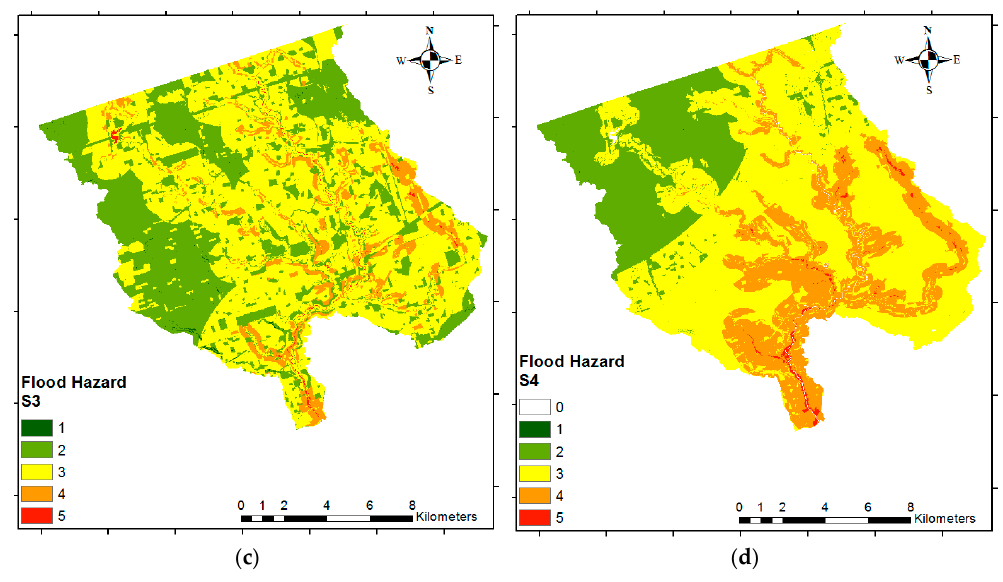
Figure 6. Flood hazard maps; ( a ) S1; ( b ) S2; ( c ) S3; ( d ) S4.